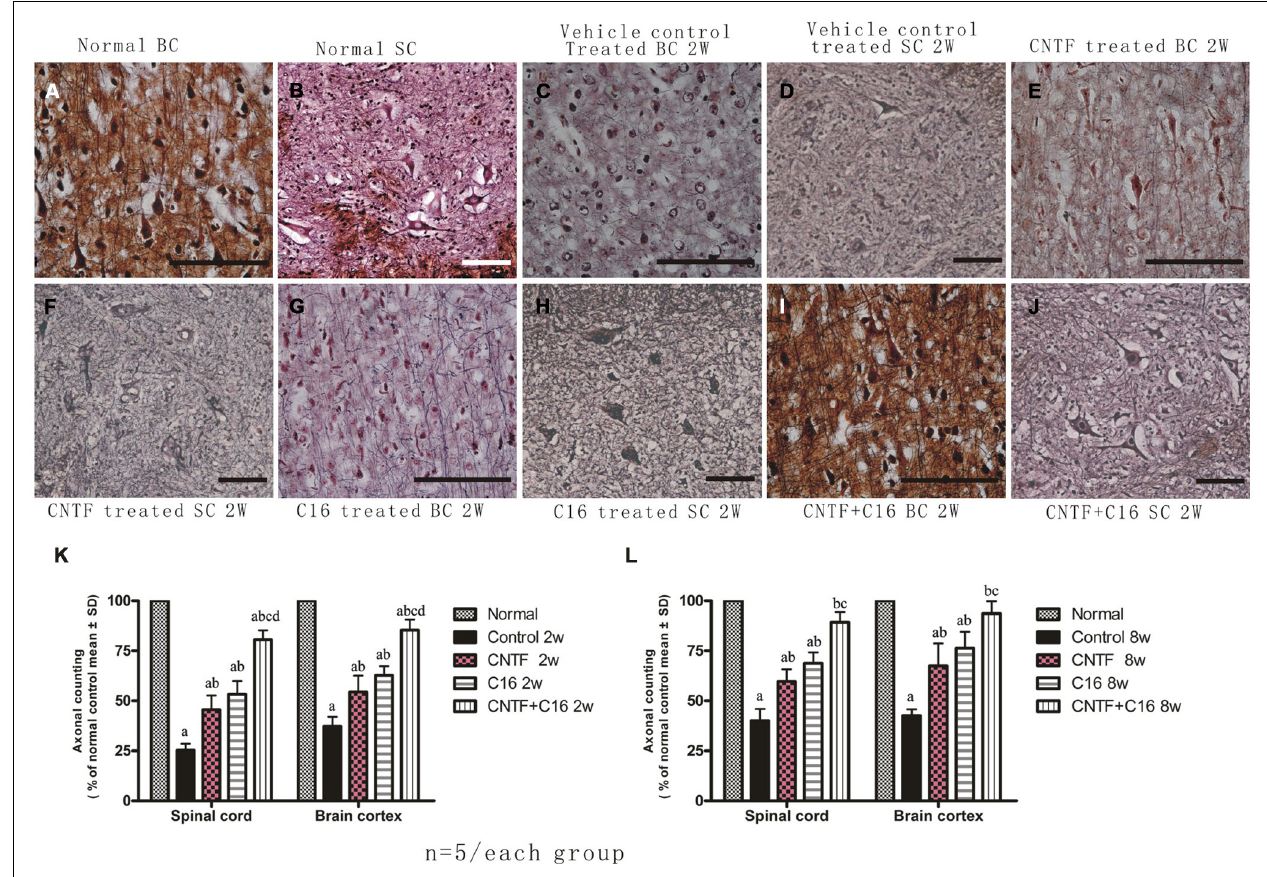
FIGURE 4 |Treatment with CNTF or C16 alleviated axonal loss in the spinal cord and cerebral cortex, as revealed by Bielschowsky staining, [(A,C,E,G,I): coronal sections of brain motor cortex; (B,D,F,H,J): traverse sections through anterior horn of lumbar spinal cord], bar = 100 μ m. At week 2 post-immunization, (A,B) normal control group, (C,D) vehicle-treated EAE rats [ (C) axons were undergoing gradual loss and exhibiting deformed and ovoid formation, the neurons